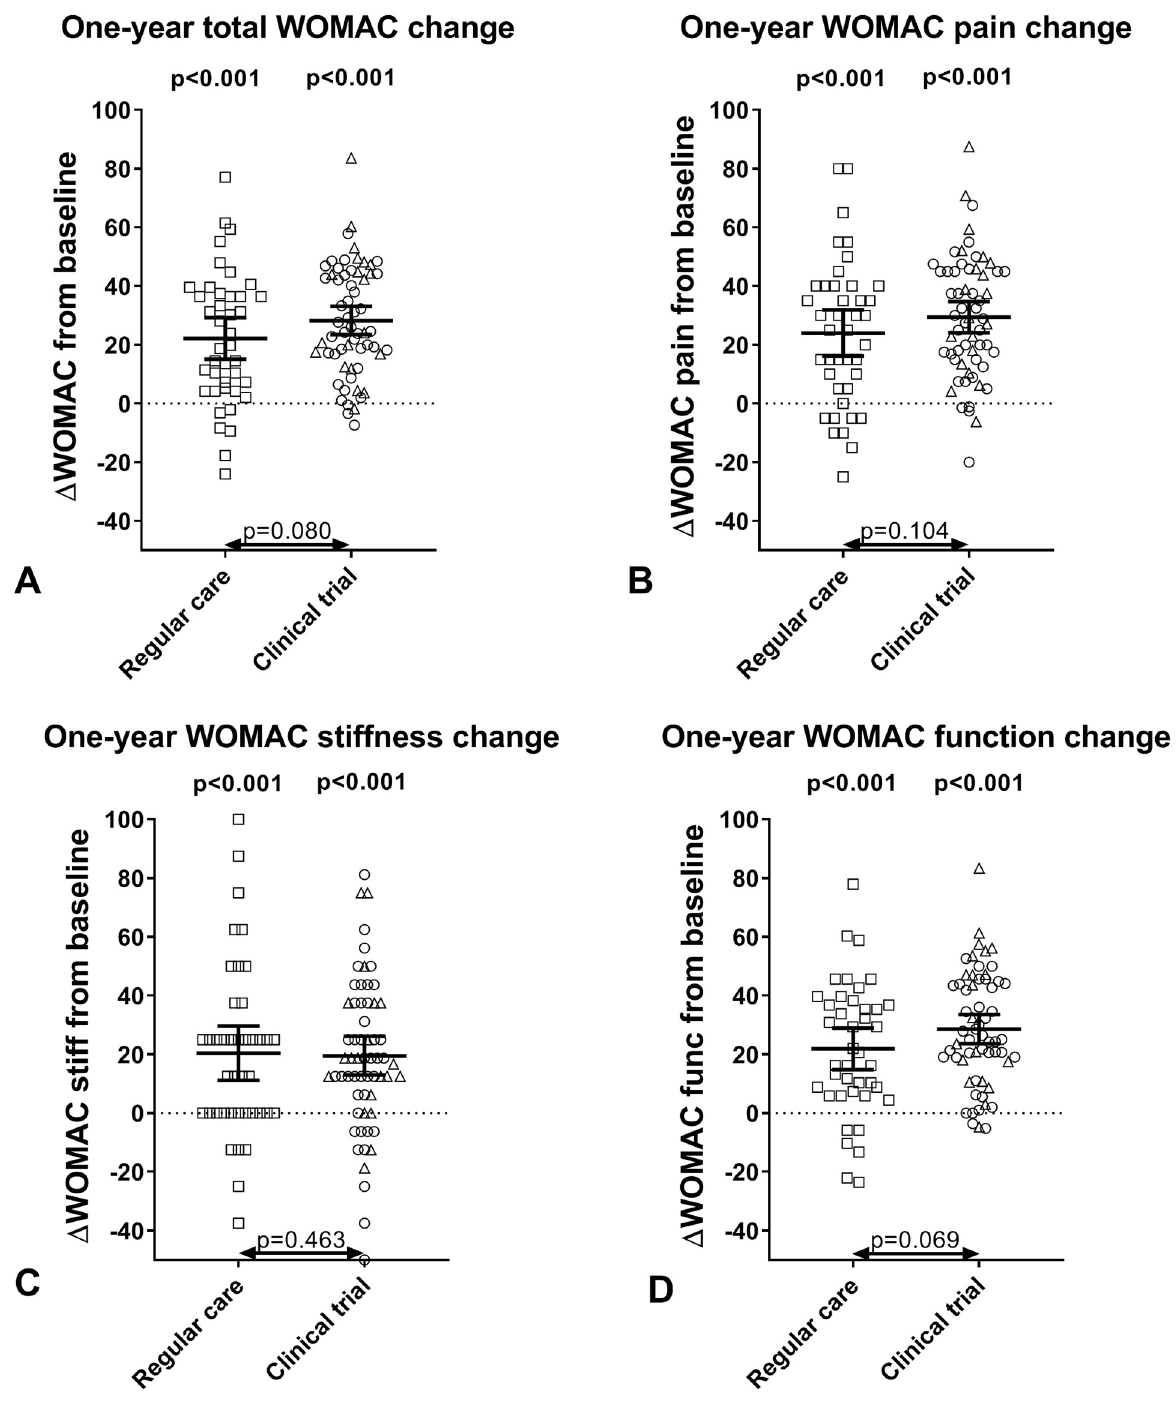
Fig 4. One-year WOMAC change for patients treated with knee joint distraction. One-year change in Western Ontario and McMaster Universities Osteoarthritis Index (WOMAC) total score (A) and the pain (B), stiffness (C) and function (D) subscales for patients treated with knee joint distraction in regular care and in OPS/RCT clinical trials (OPS = open prospective study; RCT = randomized controlled trial). P-values above groups indicate significant changes at one year compared to baseline while p-values between groups indicate the significance of differences between groups, corrected for baseline values and distraction duration. Each dot represents a patient (for trial patients: triangles represent OPS patients and circles RCT patients); bars represent mean and 95% confidence interval.